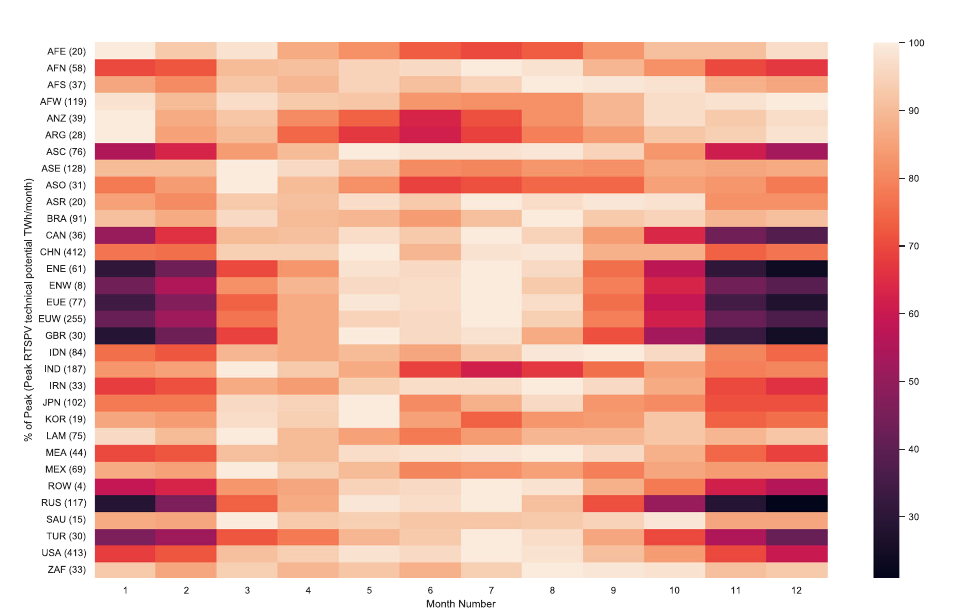
Fig. 6 Monthly potential variability for 32 world regions. The heatmap represents the monthly variability of regional potentials. The values in the parenthesis represent the highest monthly potential for the region. The color-coded heatmap represents % of the maximum monthly potential of the region. Europe (EUW, EUE) has shown high intra-annual variability of the potential, with the maximum potential being realized in the summer months. In the southern hemisphere, the maximum potential is realized in the winter months. Africa West (AFW) has shown the lowest variability in the monthly